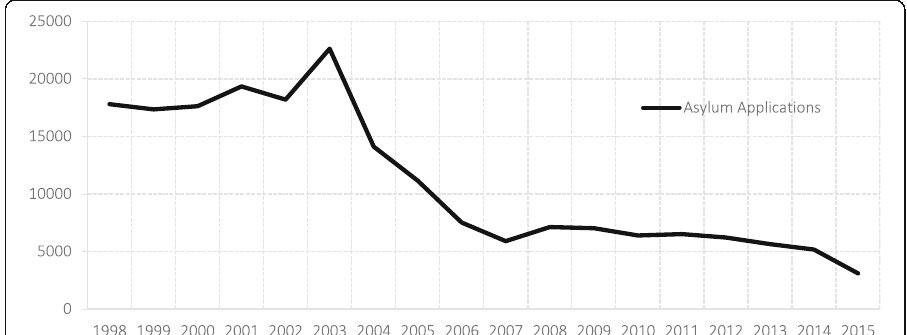
Fig. 1 Asylum applications of Turkish citizens in EU-28, 1998 – 2015. Source: Eurostat